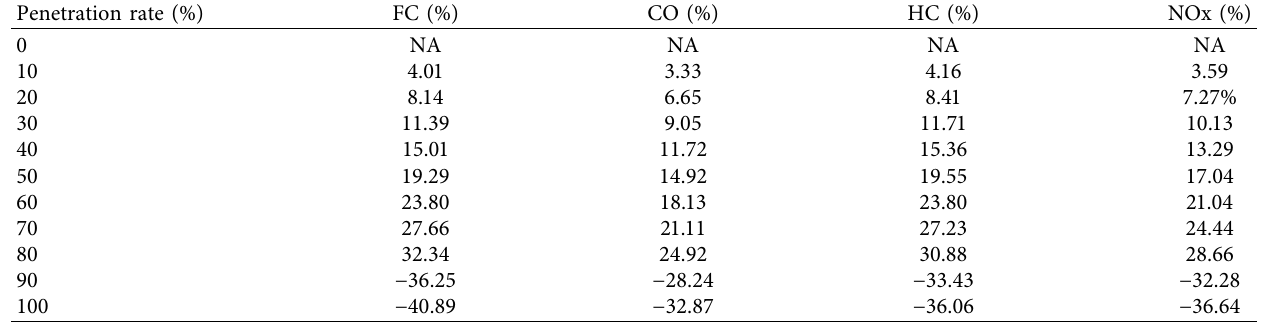
Figure 9: Fuel consumption and traffic emission for different permeability of CAVs (Scenario 3). (a) Fuel consumption. (b) CO. (c) HC. (d) NOx. Table 8: Percentage reduction in fuel consumption and traffic emissions (Scenario 3).